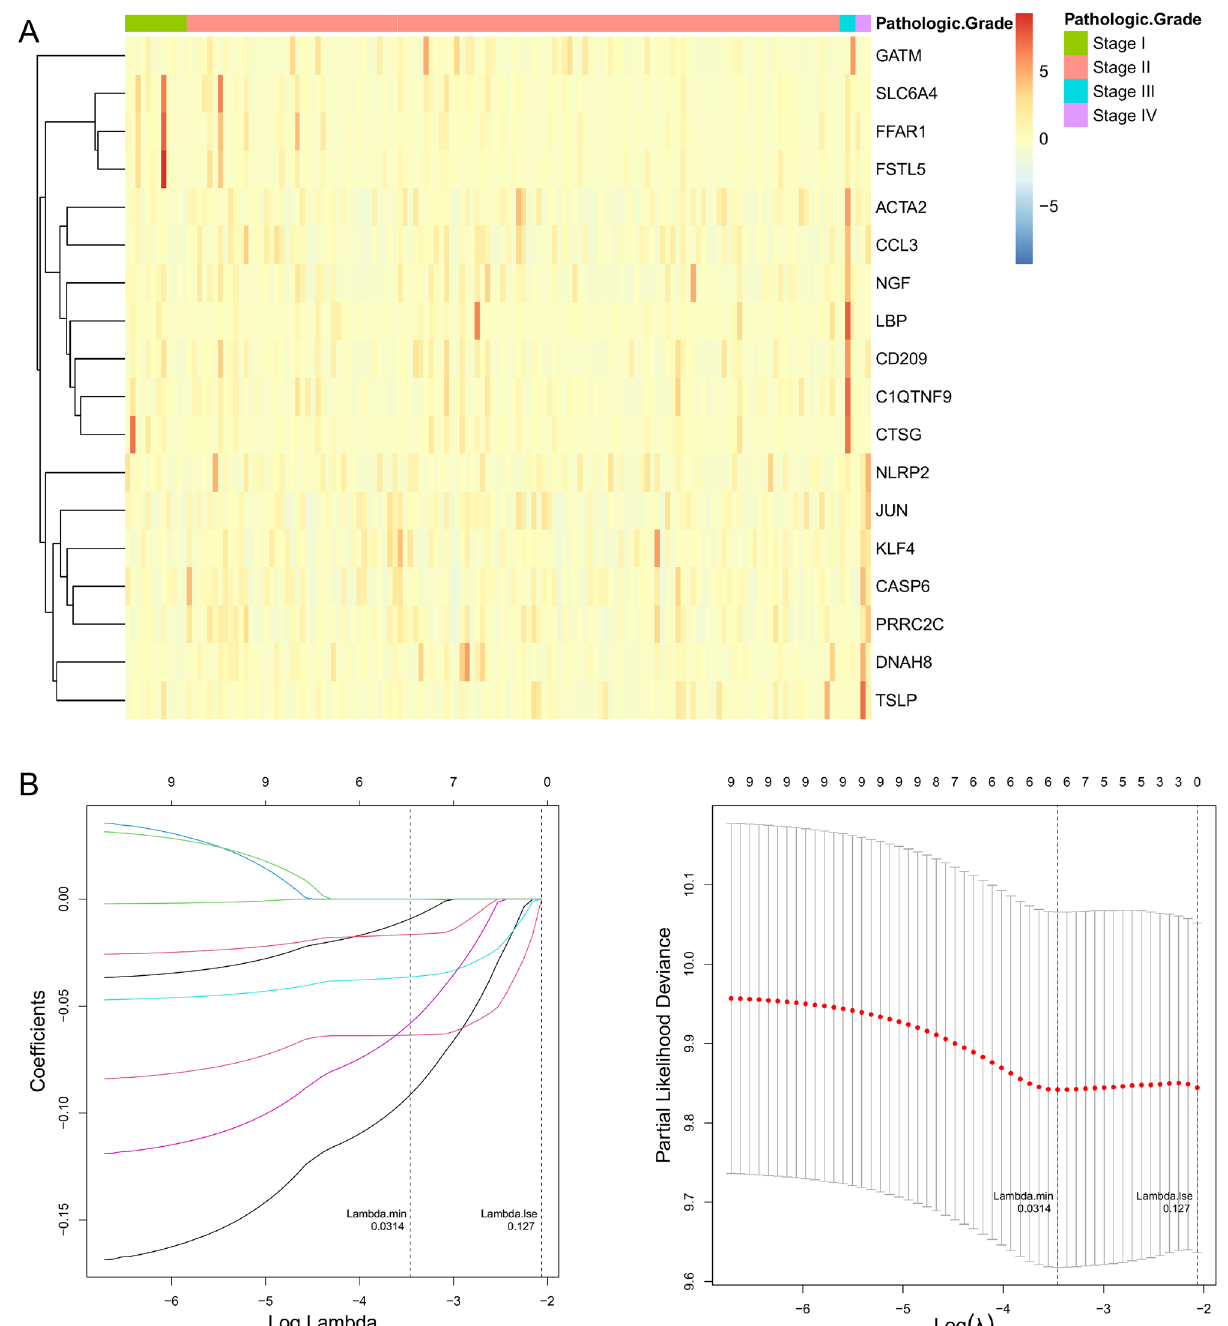
Figure 2. Construction of risk signature based on the expressions of the 18 pyroptosis and inflammasome- related genes. ( A ) Heatmap (green: low expression level; red: high expression level) of the pyroptosis and inflammasome-related genes between different pathologic grade in PDAC. ( B ) LASSO regression of the 9 OS-related genes and cross-validation for tuning the parameter selection in the LASSO